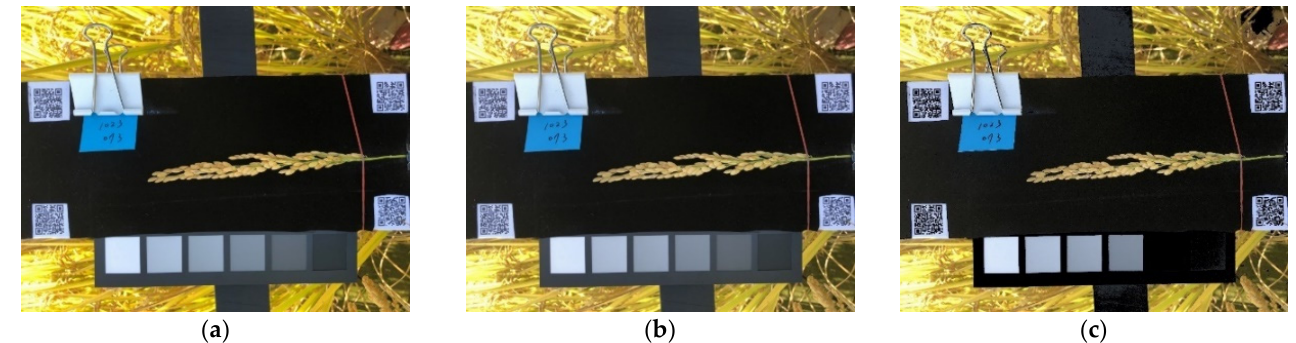
Figure 7. Image color calibration including contrast correction ( a ), gamma correction ( b ), and halation removal ( c ).